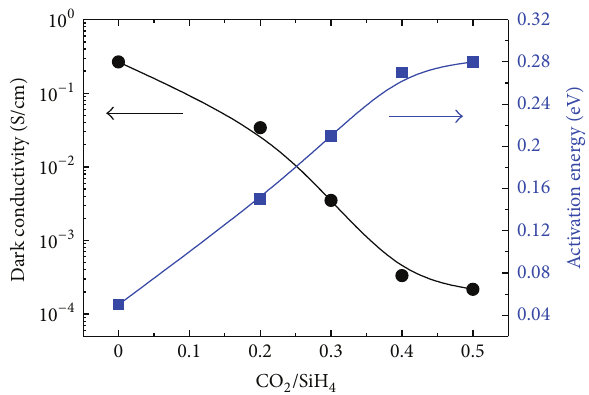
Figure 1: Dependence of the dark conductivity and activation energy on the CO 2 /SiH 4 ratio for p- 𝜇 c-Si 1−𝑥 O 𝑥 :H films.